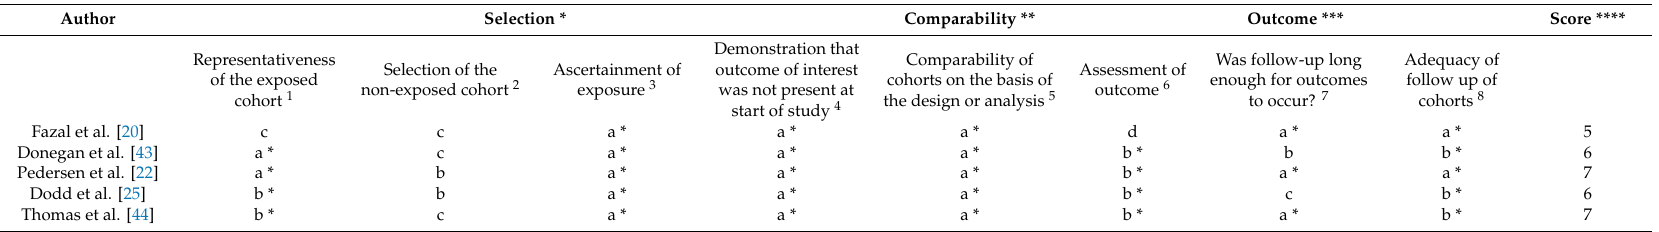
Table 5. Quality assessment of the cohort studies considered, according to the Newcastle-Ottawa Scale